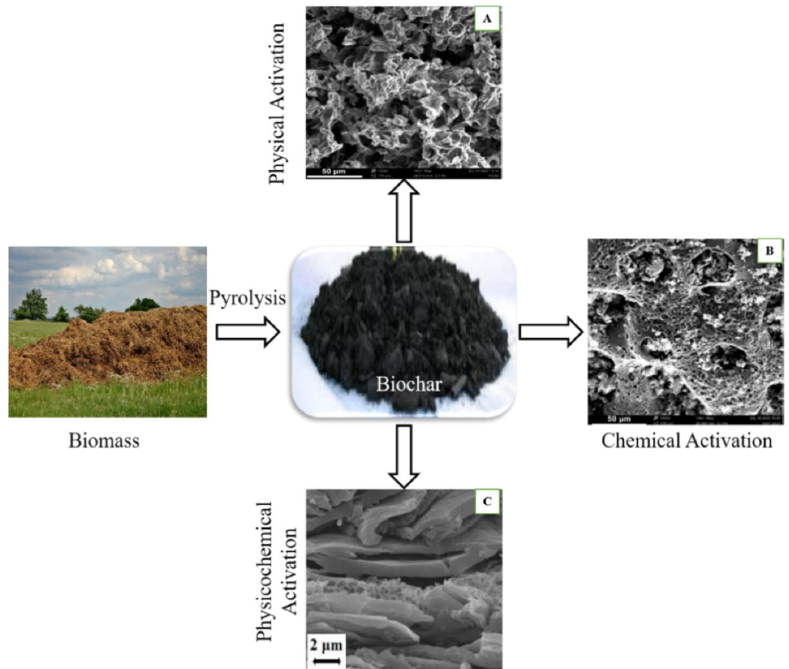
Figure 4. SEM images of activated carbon production via physical, chemical, and a combination